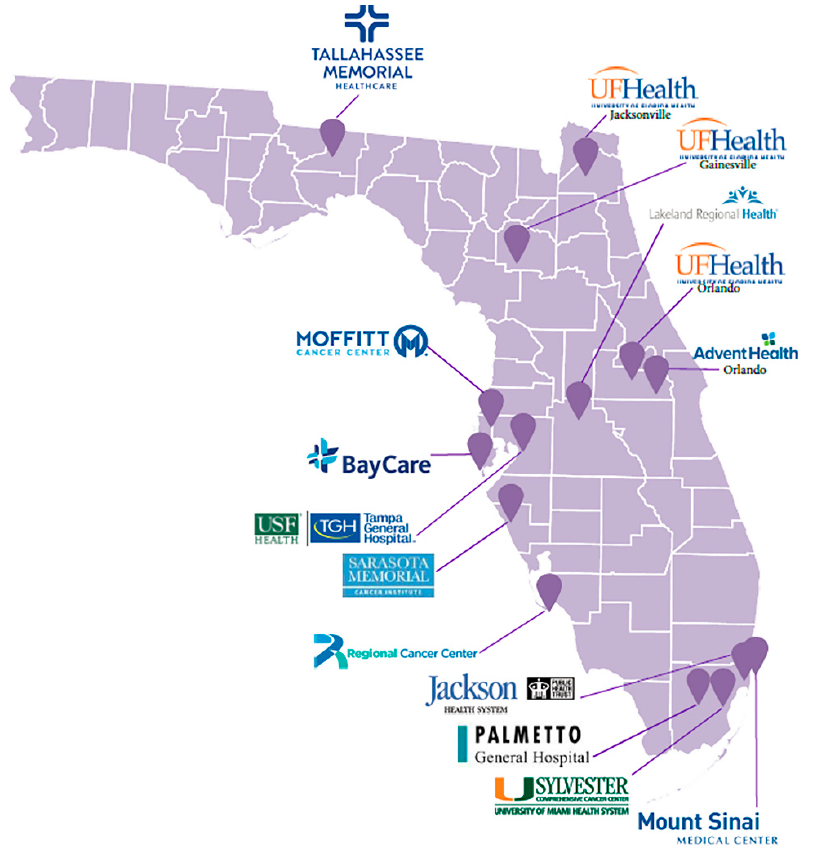
Figure 1. Florida Pancreas Collaborative Study Sites.